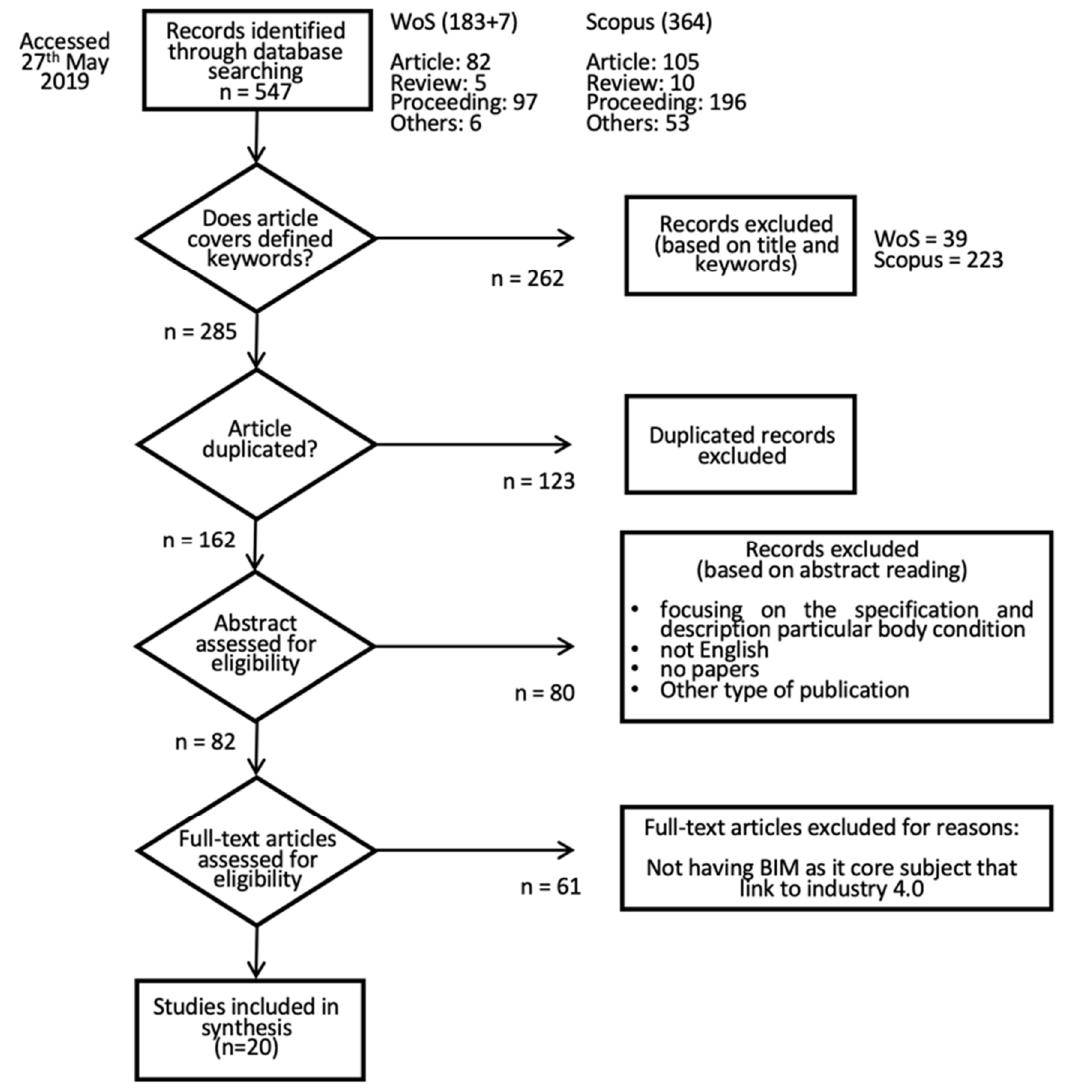
Figure 1. Preferred Reporting Items for Systematic Reviews and Meta-Analyses (PRISMA) flow diagram of search process.